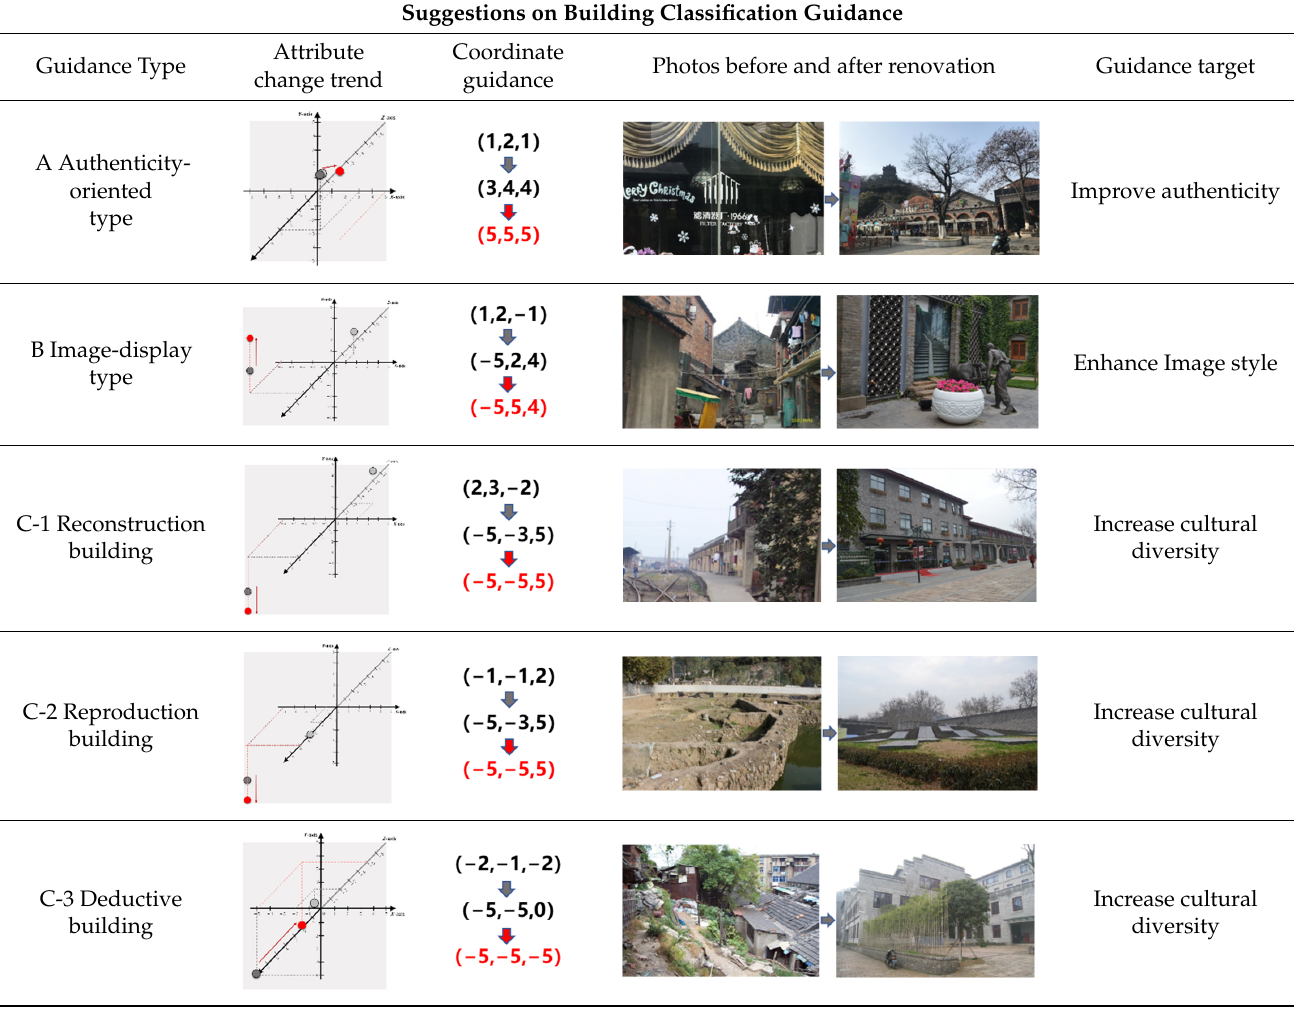
Table 4. Suggestions on building classification guidance.